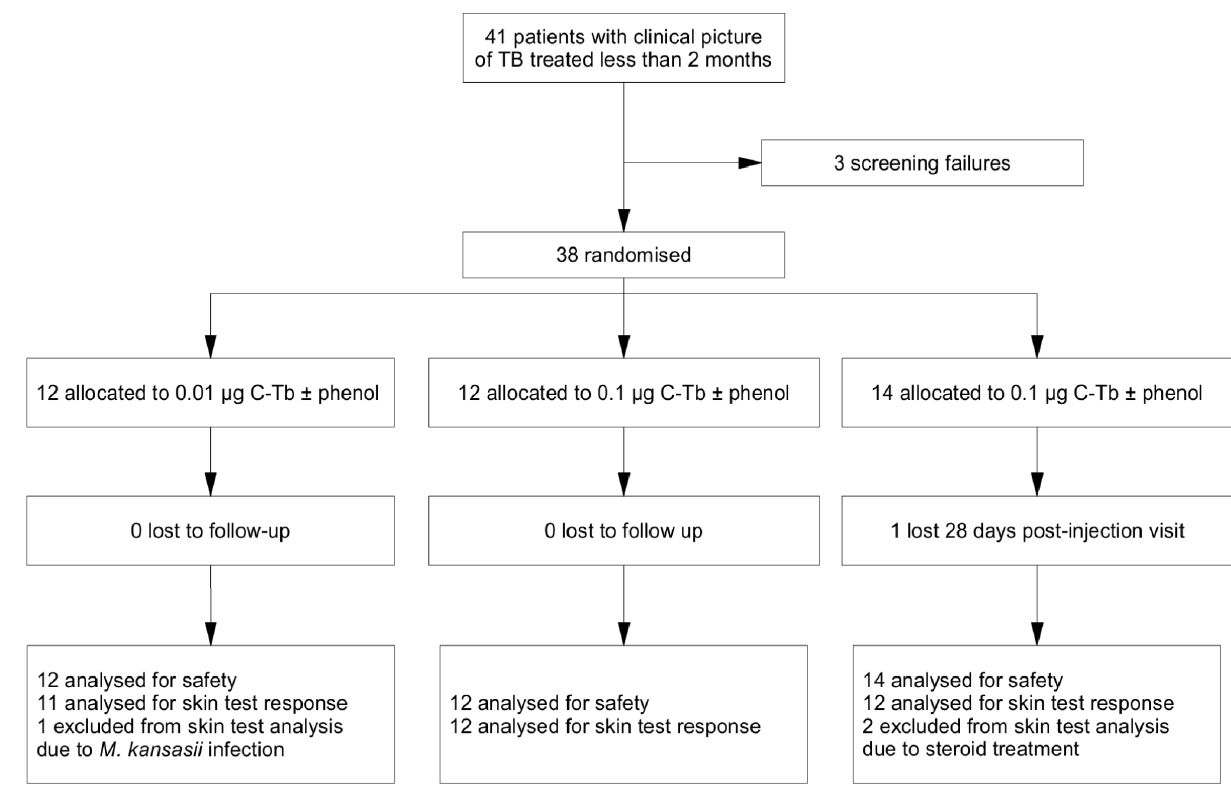
Figure 1. Flow diagram of dose-finding trial. TB patients received C-Tb (unpreserved and phenol preserved) in either arm. 3/11 (0.01 m g C-Tb) and 13/24 (0.1 m g C-Tb) had a culture or PCR confirmed TB at inclusion, the rest were smear (2/11 and 2/24) or IGRA (6/11 and 9/24) positive.